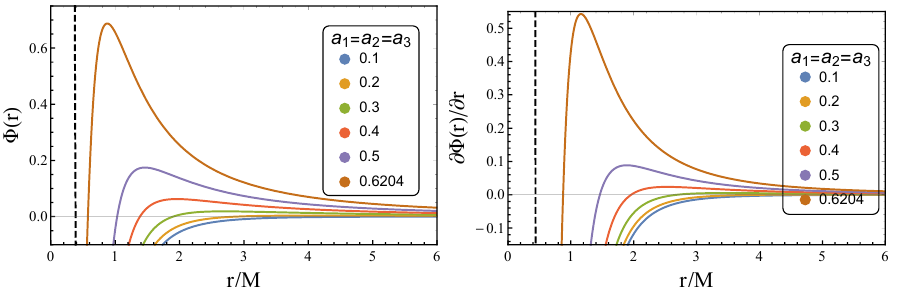
Figure 1. The radial profile of the gravitational effective potential Φ ( r ) and its first derivative ∂ Φ ( r ) / ∂ r for D = 7 are plotted for various combinations of black hole rotating parameters. Note that in both panels, vertical line refers to the horizon for a 1 = a 2 = a 3 = 0.6204 corresponding to a nearly extremal black